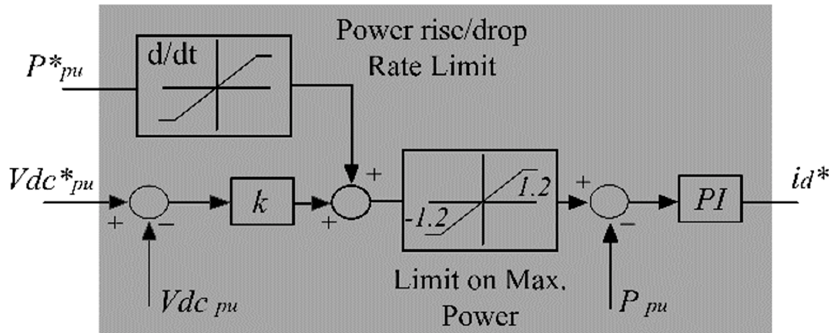
Figure 2. Direct voltage droop controller.